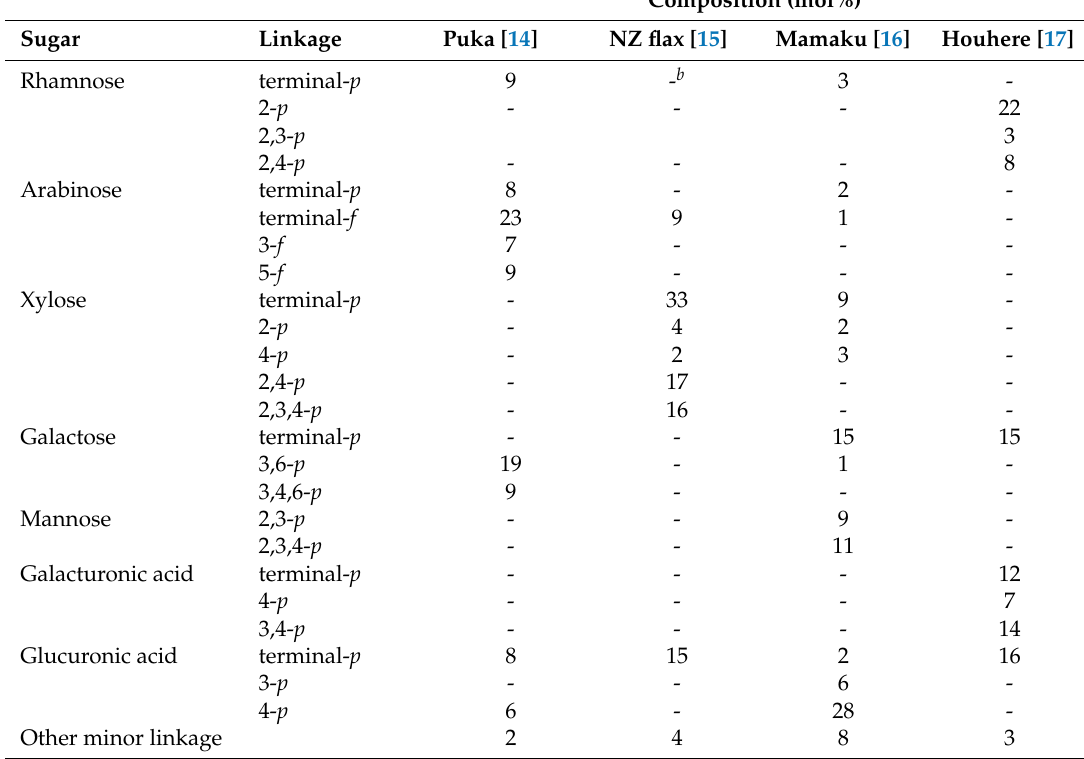
Table 1. Glycosyl linkage compositions of the gum and mucilage polysaccharides from NZ native